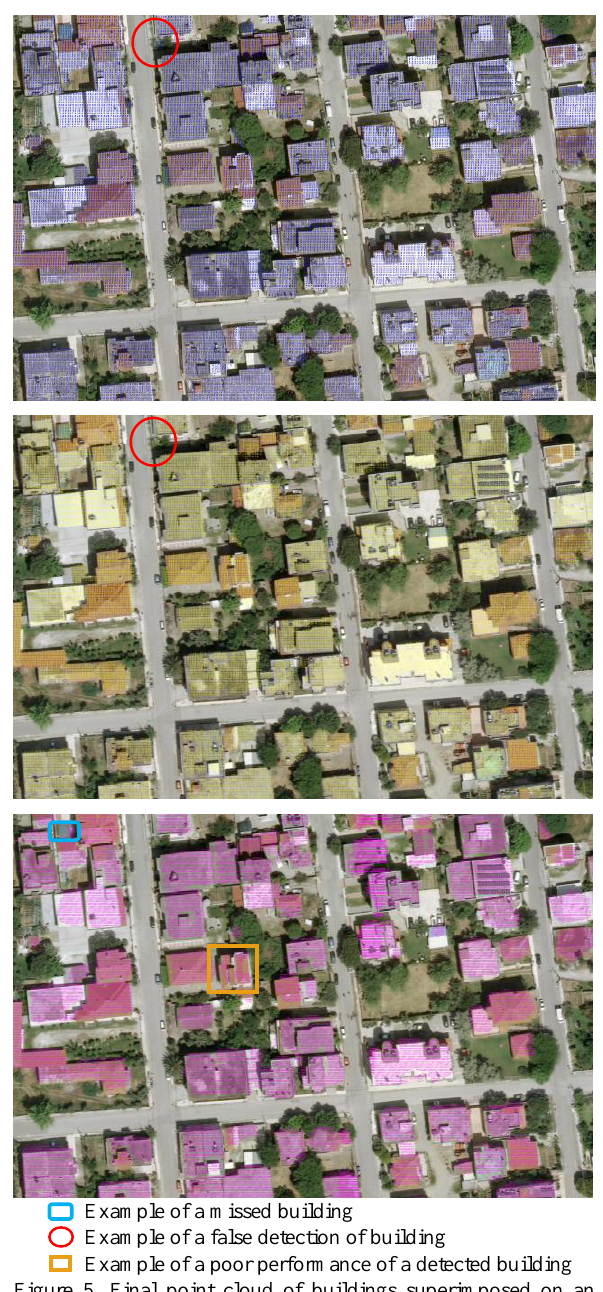
Figure 5. Final point cloud of buildings superimposed on an orthoimage, using the bilateral filtering approach coloured in blue (top) and the scan line smooth filtering approach coloured in yellow (middle) at the LIDAR point cloud; the CIR point cloud from SGM coloured in magenta (bottom).